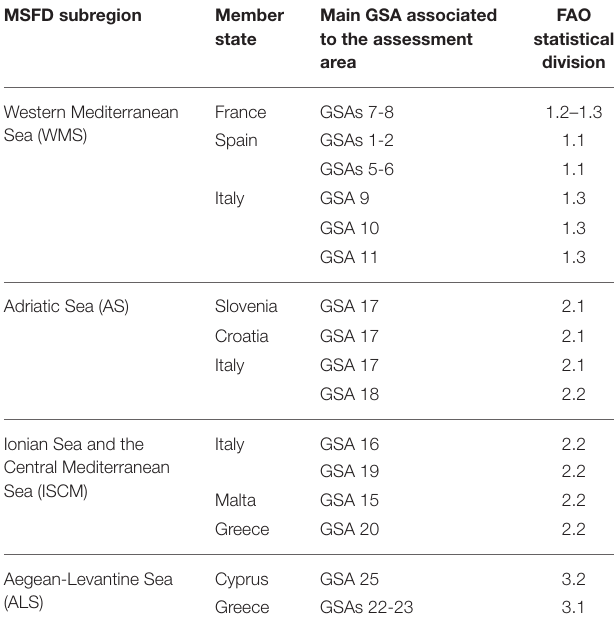
TABLE 2 | Assessment areas identified by each Mediterranean EU member states per single MSFD subregion and overlap with FAO Statistical